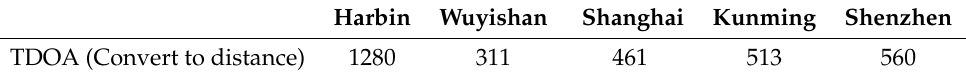
Table 4. TDE results of AM I/Q data (km).